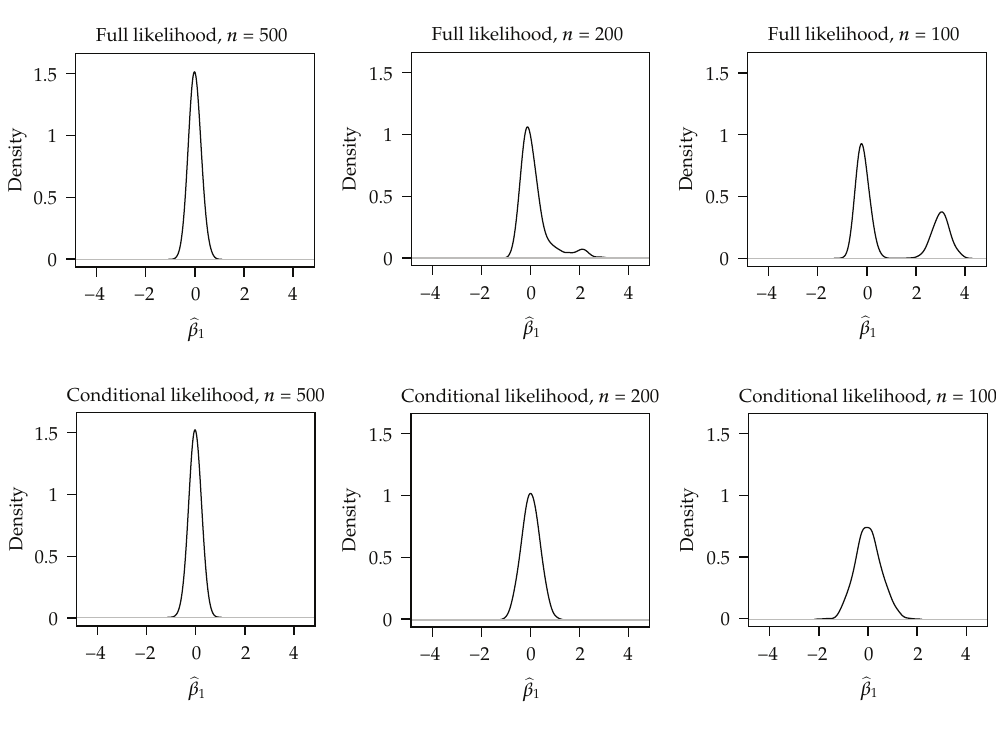
Figure 3: Sampling distributions for maximum likelihood estimates of regression coe ffi cient β 1 from 1000 replications; normal model fitted to gamma data (cid:5) Y i ∼ Gamma (cid:5) 4 , 1 (cid:6)(cid:6)